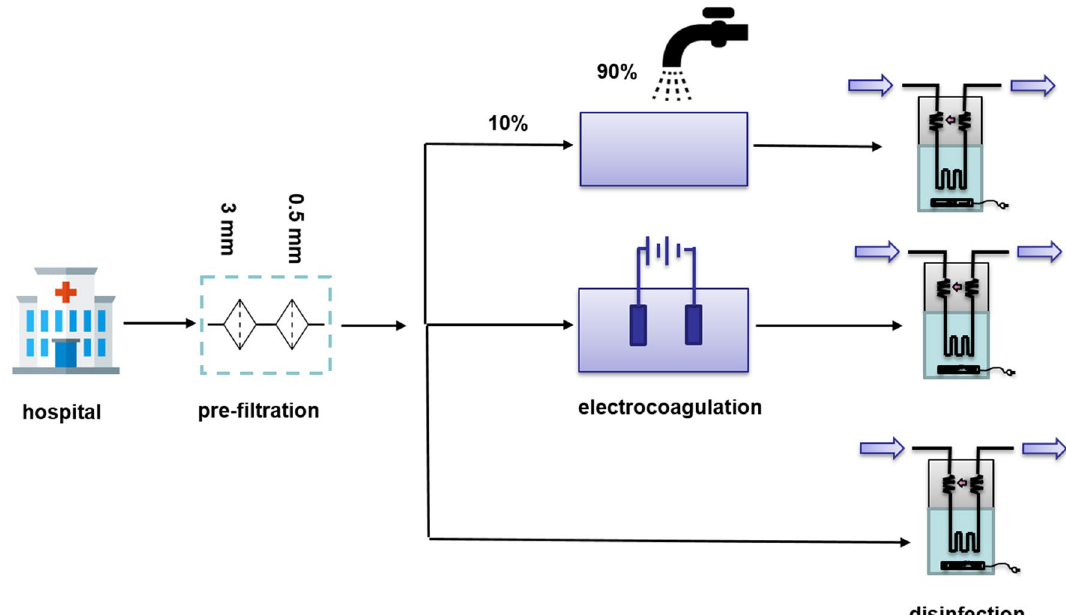
Fig. 2 Schematic representation of the experimental